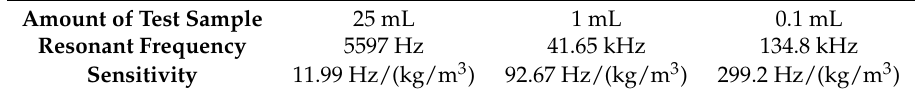
Table 3. Resonant frequencies and sensitivities of the proposed Helmholtz resonator (HR) after miniaturization (analytical results).